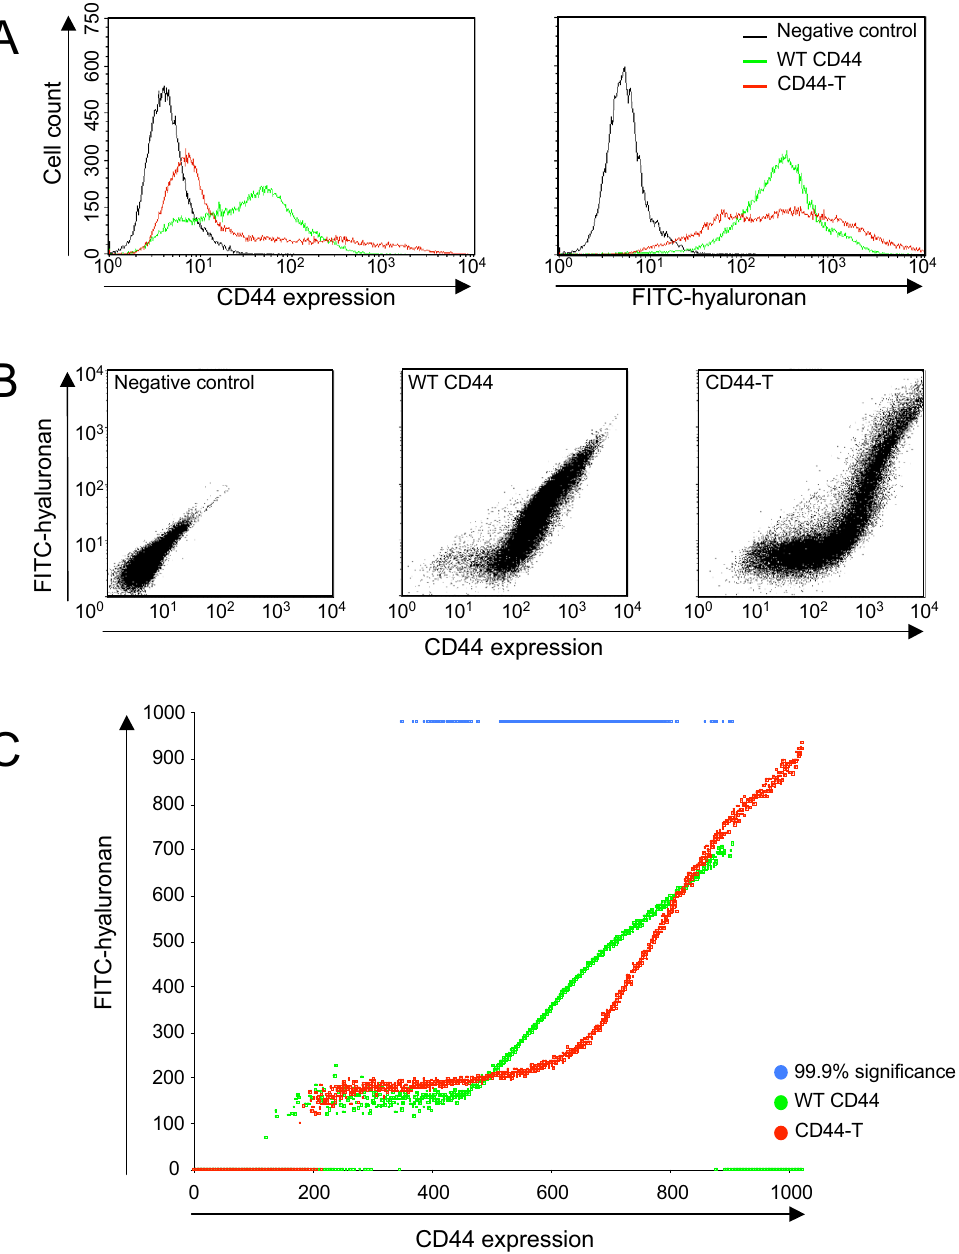
Figure 2 Use of the spreadsheet method incorporating students' t-test analysis to examine hyaluronan binding function of wild type and mutant CD44 receptors expressed in AKR1 cells AKR1 cells transfected with WT CD44 or CD44-T were stained for three-colour flow cytometry as described in the Methods. For the negative control, WT CD44 expressing cells were stained with FITC-BSA and rabbit anti-mouse PE-F(ab) . The flow cytometry data is displayed as follows: A , histo- 2 gram plots showing CD44 expression or FITC-hyaluronan binding. B , two-parameter dot plots correlating FITC-hyaluronan binding against CD44 expression. C , the data was analysed using the spreadsheet method (see text for further details). Where there were 3 cells or fewer for a given PE fluorescence channel, the point is plotted at 0 on the y-axis. Values are arbitrary flu- orescence units. Analysis used the spreadsheet method including application of a students' t-test. Where there was a significant statistical difference in FITC-hyaluronan binding between WT CD44 and CD44-T at the 99.9% level, a point is plotted at 980 on the